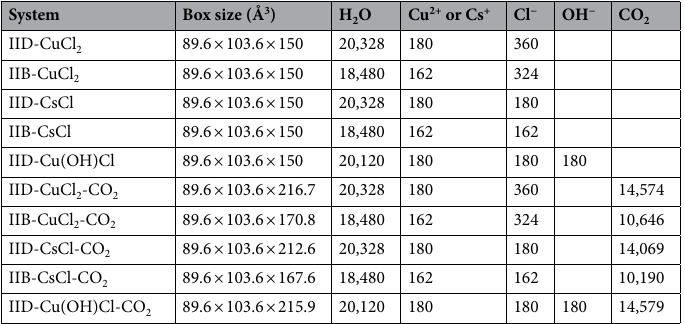
Table 1. Simulation box size and number of molecules in each simulation system. In the IID-Cu(OH)Cl-CO 2 system, kerogen type IID is simulated with Cu 2+ , OH − , Cl − , CO 2 , and H 2 O. In the IIB-CsCl system, kerogen type IIB is simulated with Cs + , Cl − , and H 2 O.